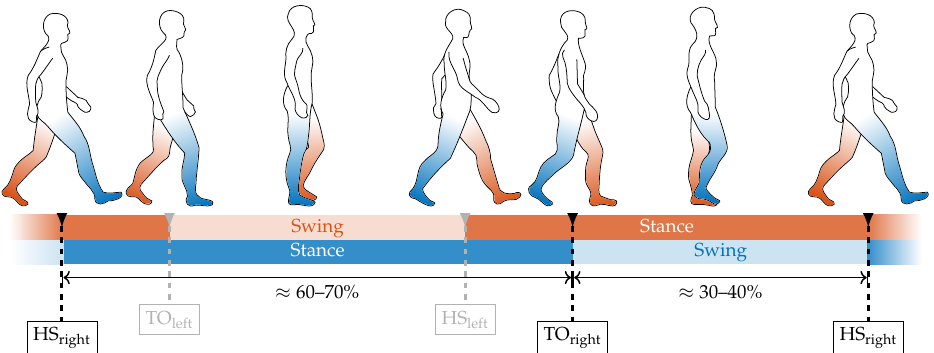
Figure 7. The two main components of the basic gait cycle consist of the stance phase and the swing phase. During normal gait, the stance phases of both left and right leg overlap during the double support phase. The stance and swing phases are separated by the heel strike (HS) and toe off (TO) event, which are the key characteristic points to be extracted from the